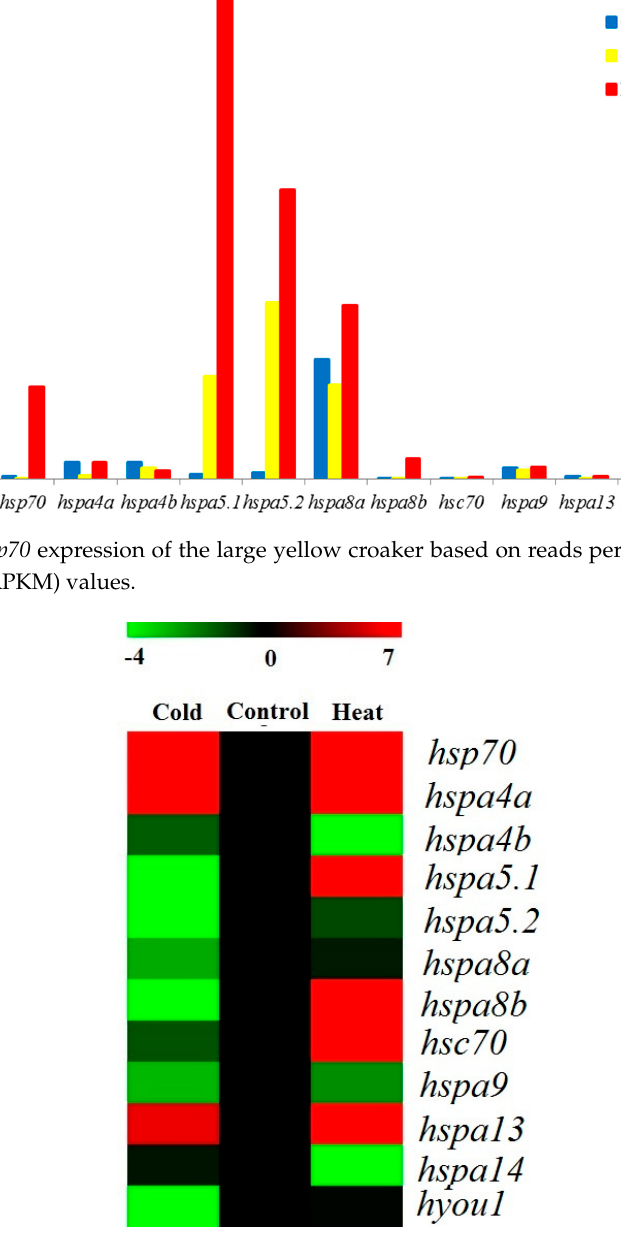
Figure 5. Heat map of hsp70 expression under cold and heat stress treatments based on the fold change (log 2 ) in RPKM values. Table 2. Log 2 fold change of large yellow croaker hsp70 gene expression in liver under thermal stress. The significant genes ( p value < 0.05, reads number >10, absolute log 2 fold change >2) and their